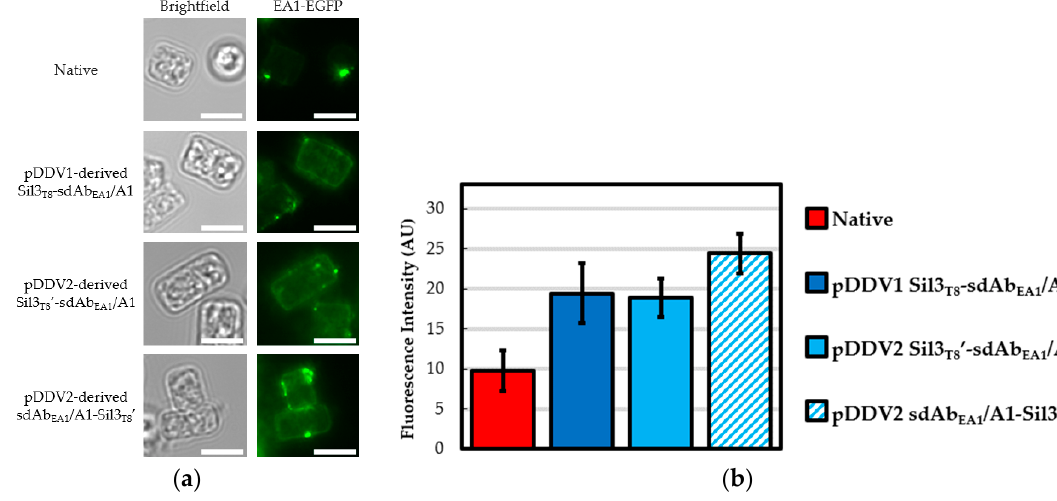
Figure 2. sdAb EA1 /A1 in vivo functionalized biosilica. Diatom biosilica was isolated from native T. pseudonana and cell lines transformed with expression constructs containing various Sil3 T8 -sdAb EA1 /A1 fusions. Presence of functional, in vivo assembled, biosilica-tethered sdAb EA1 /A1 was confirmed by ability to bind EA1-EGFP protein. ( a ) Epifluorescence images of representative frustules showing different EA1-EGFP binding potentials. Given that S-layer proteins like extractable antigen 1 (EA1) (and, by extension, the EA1-EGFP used here) are self-assembling [31], the punctate fluorescence observed in all four panels is expected and contributes to the fluorescent signal observed for the native frustules. All calibration bars are 5 µ m. ( b ) Average measured fluorescence intensities in arbitrary units (AU). Error bars are 95% confidence intervals (±t × 1 SEM). For native and pDDV1-derived Sil3 T8 -sdAb EA1 /A1 biosilica frustules, n = 25 (df = 24, t = 2.06); pDDV2-derived Sil3 T8 ′ -sdAb EA1 /A1 and sdAb EA1 /A1-Sil3 T8 ′ biosilica frustules, n = 100 (df = 99, t = 1.984).